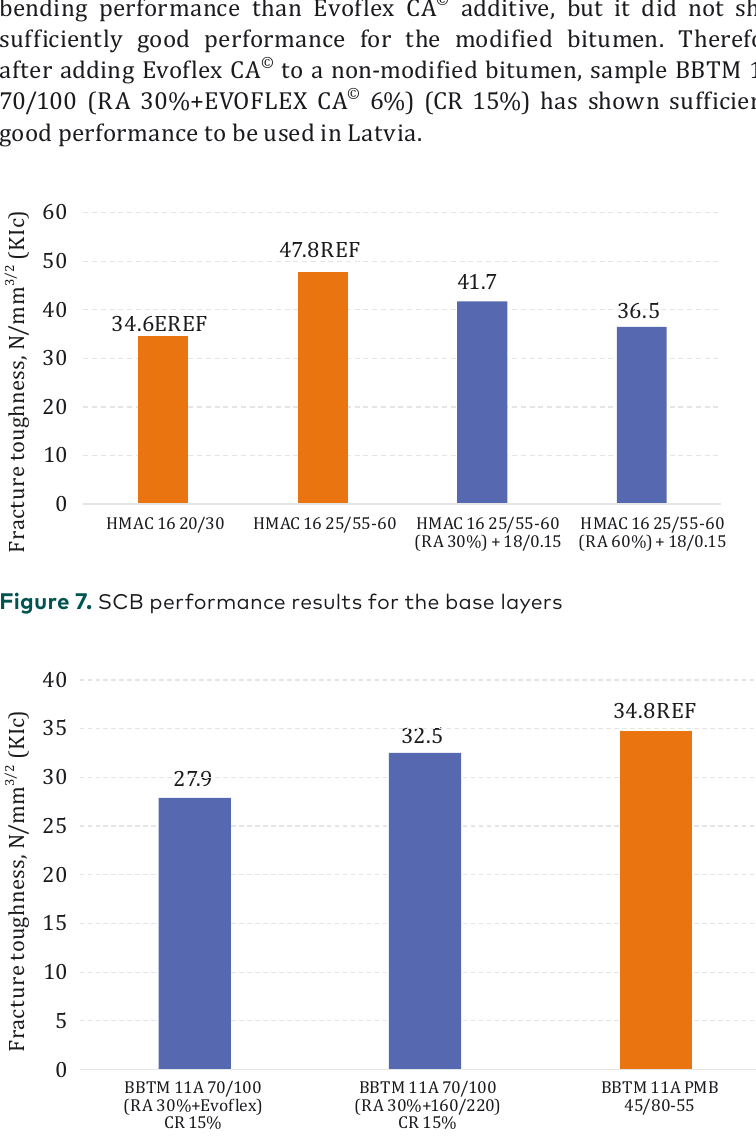
Figure 8. SCB performance results for the surface